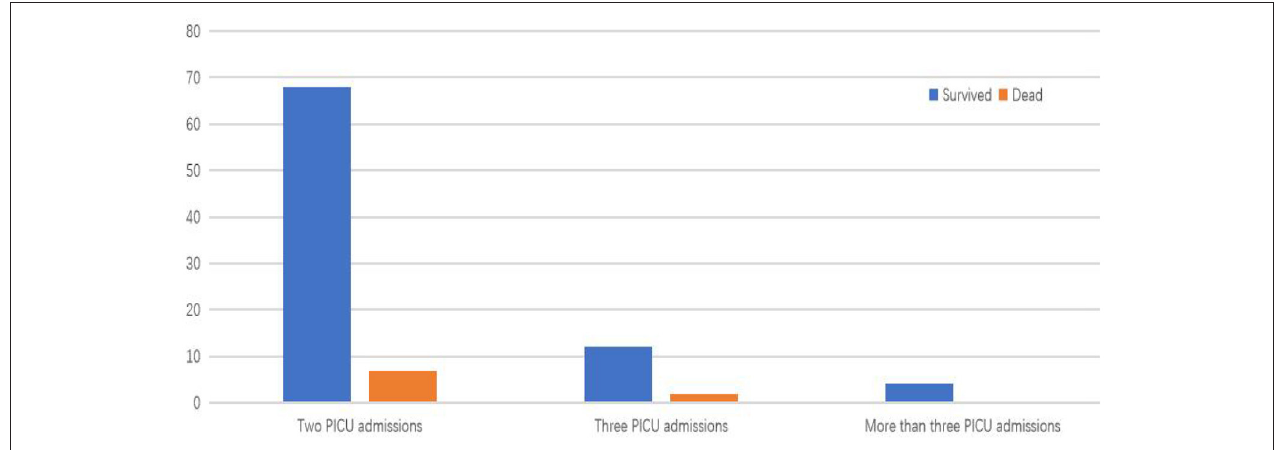
FIGURE 1 | The distribution of PICU admissions in the case